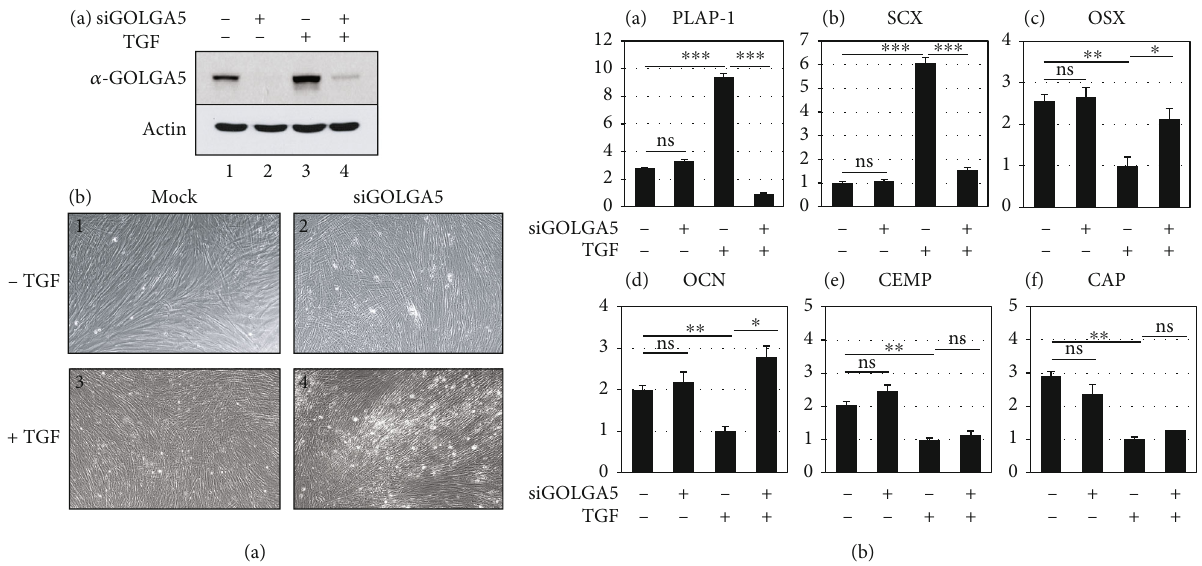
Figure 4: Depletion of GOLGA5/LG11 using siRNA construct inhibits TGF- β 1-induced PDL- fi broblastic di ff erentiation. (a) Although endogenous GOLGA5/LG11 was completely depleted (A), it was observed that cell growth was not disturbed (B). 1 and 2: undi ff erentiated hPDLSCs (-TGF); 3 and 4: TGF- β 1-induced PDL- fi broblastic cells (+TGF). (b) Transcriptional expression of the representative PDL- fi broblastic and osteo/cementoblastic markers. ns: not signi fi cant; ∗ P < 0 : 05 ; ∗∗ P < 0 : 01 ; ∗∗∗ P < 0 : 001 . Statistical analysis was performed using Student t -test ( n = 3